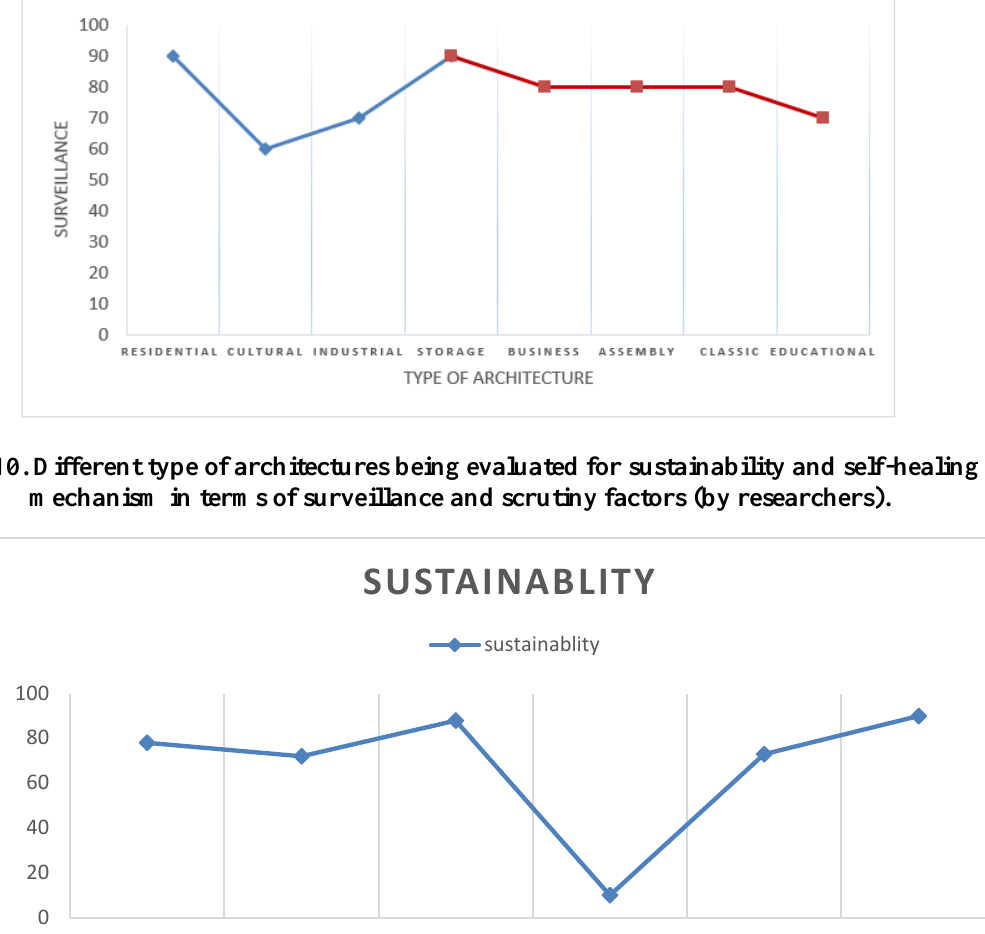
Fig. 11. Scheme showing the percentage of realization of the concepts related to sustainability in the Tobacco Building (by